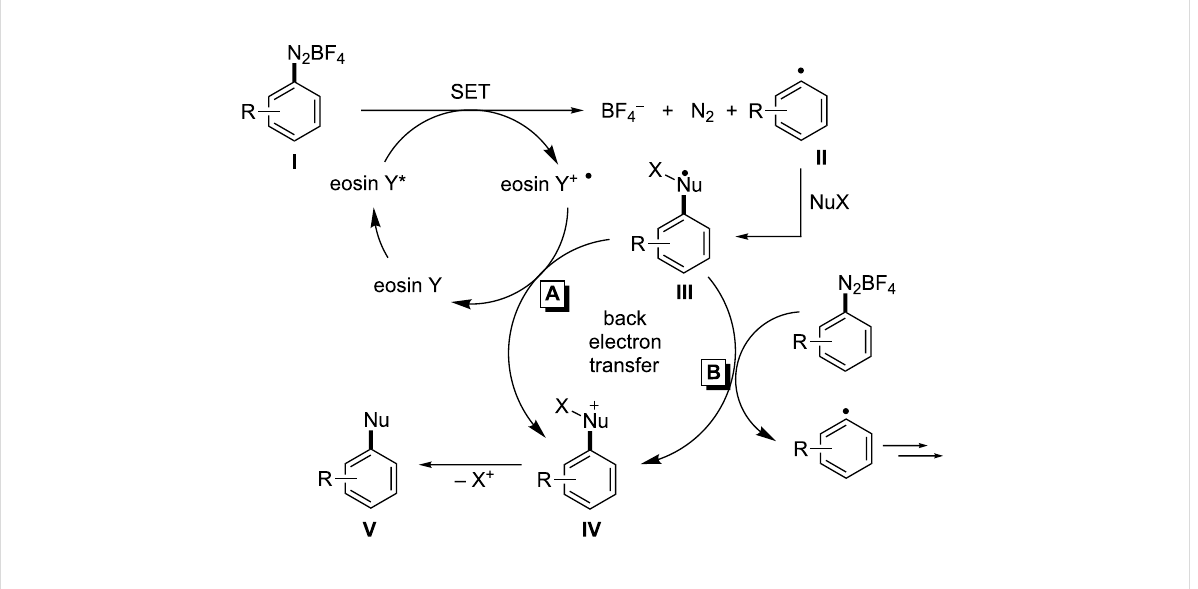
photocatalysis mechanisms by monitoring the reaction